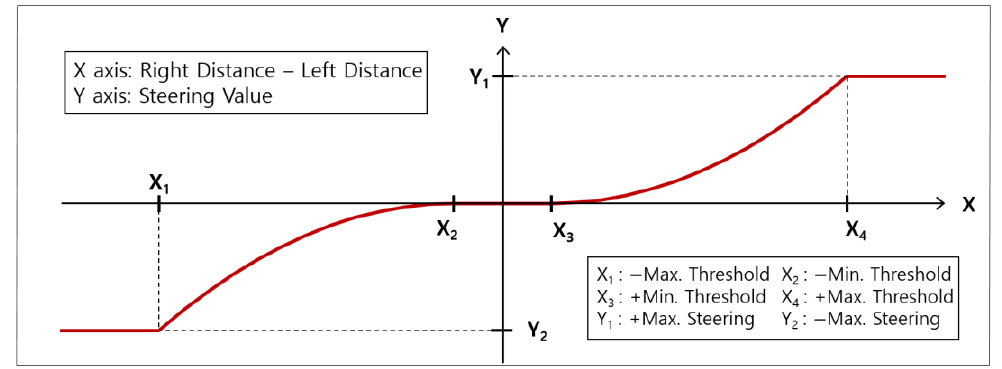
Figure 4. Relationship between the right and left distance difference, and the steering value.